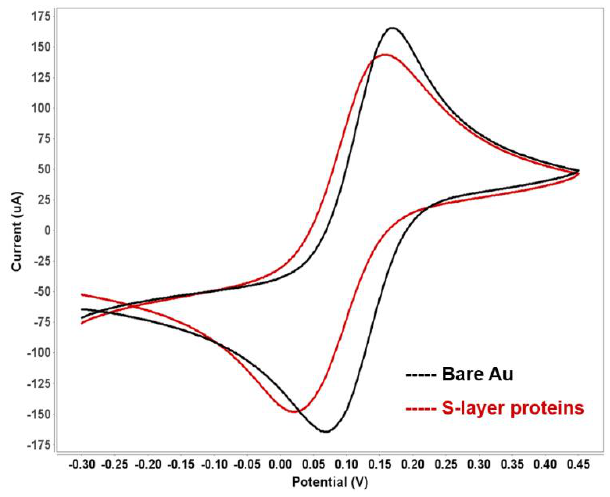
Figure 4. Cyclic voltammogram of the bare and the S-layer protein-coated gold electrode in 10 mM [Fe(CN) 6 ] 3−/4− containing 100 mM KCl at a scan rate of 50 mV/s.